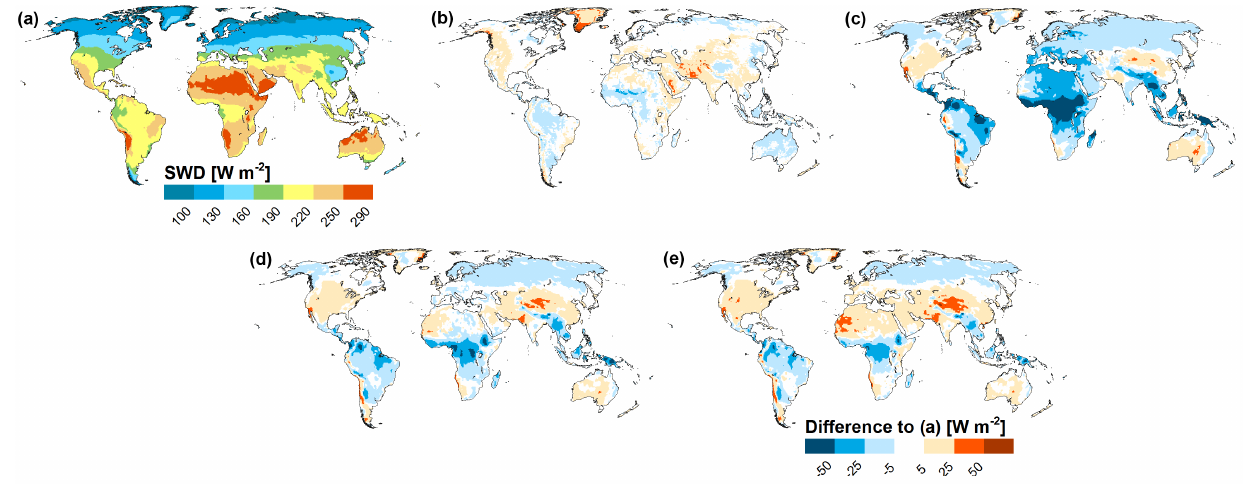
Figure A3. Long-term (1971–2000) average shortwave downward radiation of the model variants, displayed as absolute number for GSWP3 (a) and differences to the other forcings, computed as PGFv2 minus GSWP3 (b) , WFD minus GSWP3 (c) , WFD_WFDEI mi-